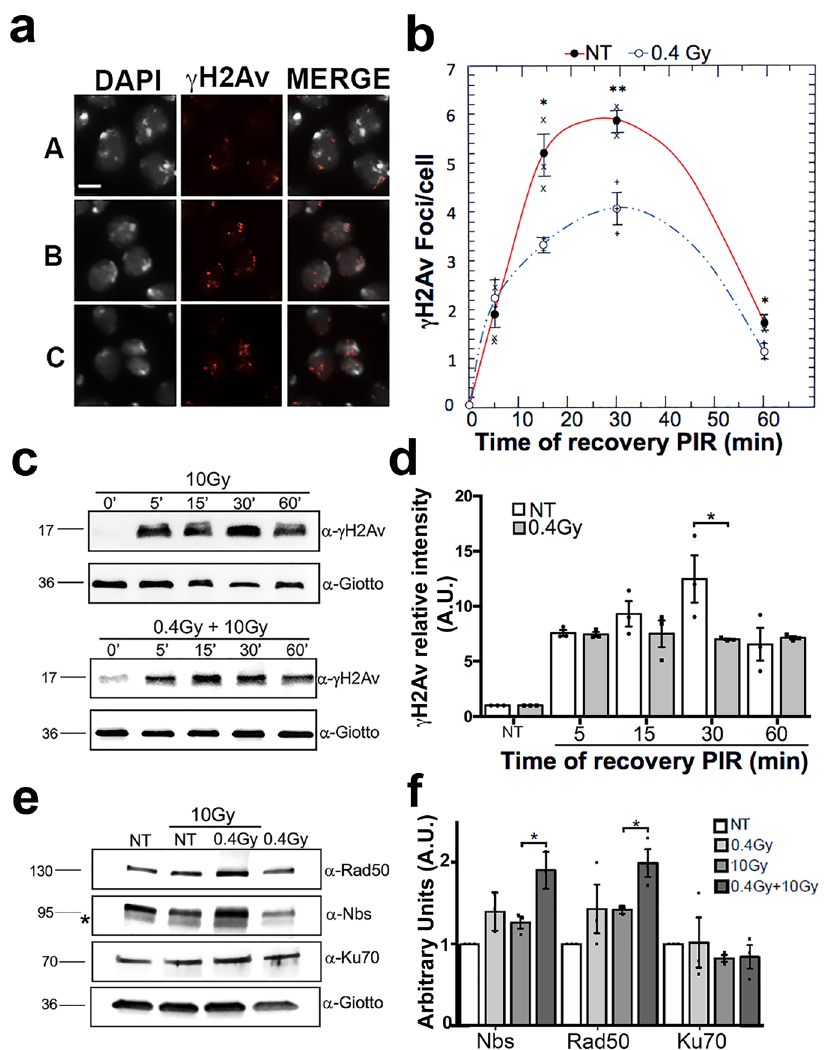
Fig. 3 DNA damage accumulation in 0.4 Gy LDR -treated and non-treated larval brains. a Anti - γ H2Av immuno fl uorescence on 10 Gy irradiated cells showing (A) low damage (0 – 3 γ H2Av spots per cell); (B) medium damage (4 – 7 γ H2Av spots per cell); (C) high damage (>7 γ H2Av spots per cell b Quanti fi cation of γ H2Av foci/cell at different PIR time points; non-pretreated (close circles) and 0.4 Gy LDR -pretreated (open circles). Error bars represent the standard errors of the mean; lines only represent guide for the eye. Values of p < 0.01 (**) and p < 0.05 (*) were considered as statistically signi fi cant (Student t -test). c Western Blot analysis of γ H2Av levels in treated and NT brains at 5 min, 15 min, 30 min, and 60 min PIR after acute IR exposure of 10 Gy. Giotto (VIB) was used as a loading control. d Quanti fi cation of γ H2Av signals from the WB analysis. WBs from three independent experiments were used for the quanti fi cation. (* p < 0.05; Student t -test); PIR post-irradiation times. e Western Blot analysis of Nbs, Rad50, and Ku70 levels in treated and non-treated brains after 4 h from acute IR exposure of 10 Gy. Giotto (VIB) was used as a loading control. f Quanti fi cation of Nbs, Rad50, and Ku70 signals from the WB analysis. NT non-treated. Bar = 10 μ